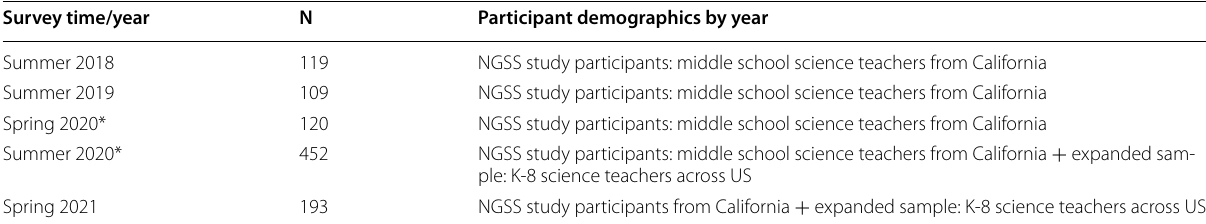
*Spring 2020 survey asked about in-person instruction prior to school closures. Summer 2020 survey asked about distance-learning instruction during school closures